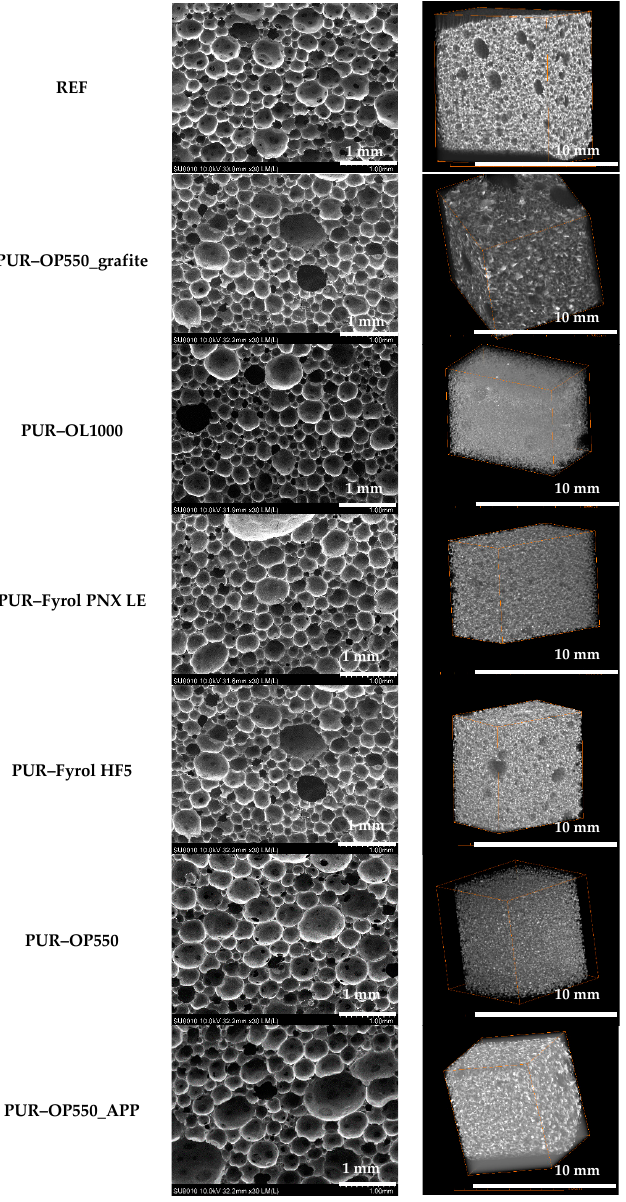
Figure 2. Microstructure of foams by flame retardant. Processing of images developed with X-ray microtomography resulted in 8-bit images, which enabled attainment of a 3D tomographic model of the test samples (Figure